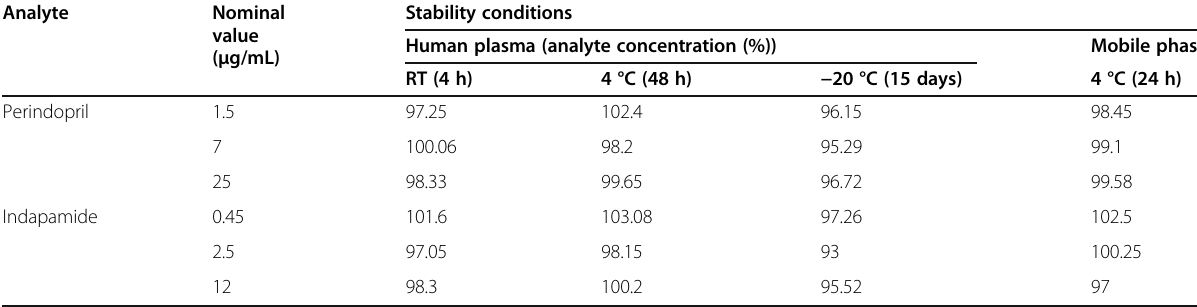
Table 4 Stability studies of analytes in human plasma and mobile phase